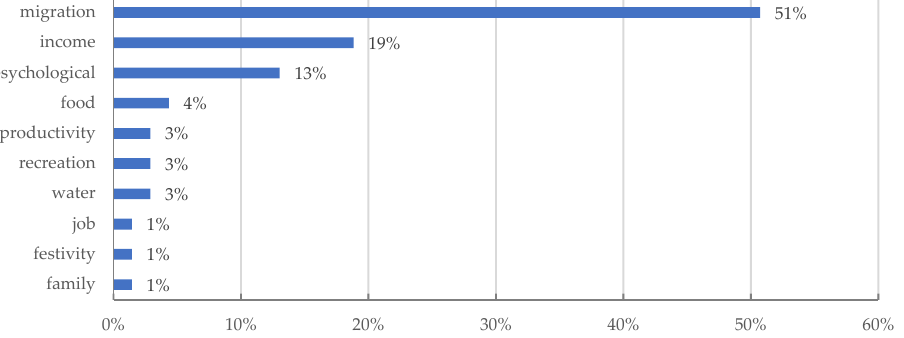
Figure 9. Perception of the main social impacts related to drought (Source: prepared by the authors).